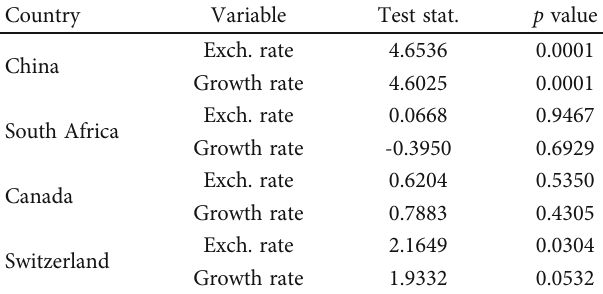
Table 5: Statistical test for serial correlation.